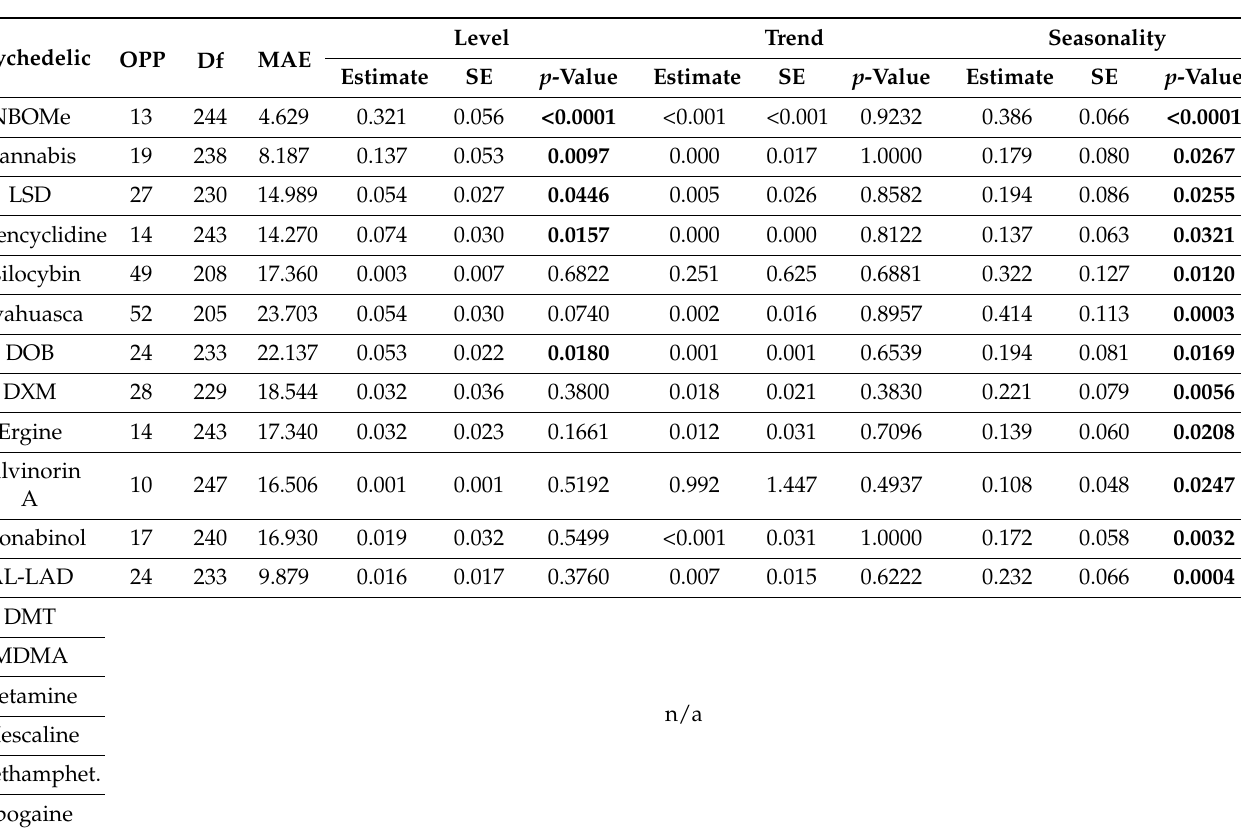
Table 1. Time series analysis for Poland: Holt–Winters exponential